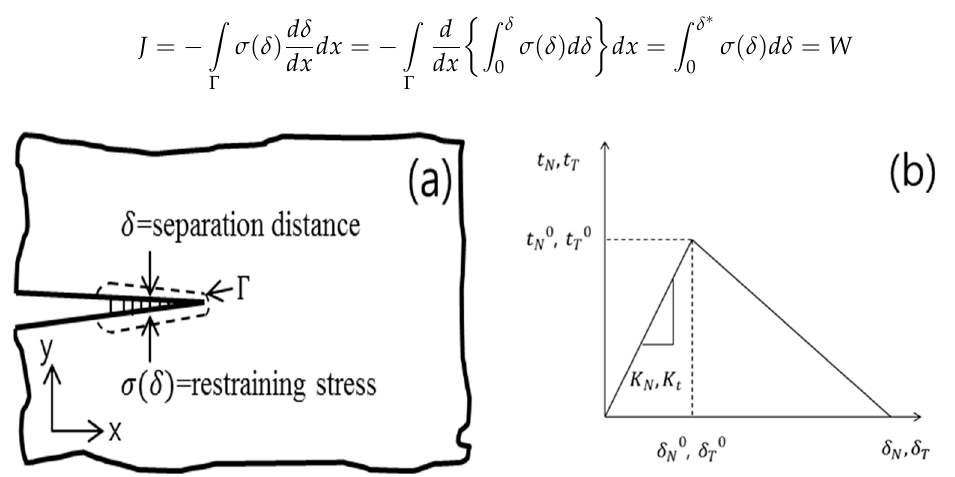
Figure 2. ( a ) Cohesive zone ahead of a crack tip, ( b ) Traction-separation response. In this study, the bilinear traction-separation law is used for calculation. The initial Figure 2b, t N , and t T are the normal and tangential components of the traction vector t ,